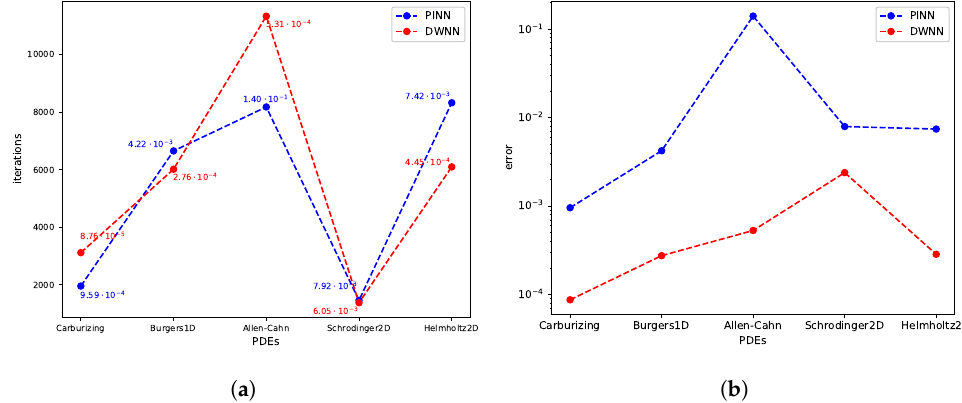
Figure 24. The comparison of iterations and errors. ( a ) Iteration comparison. ( b ) Error comparison. Table 10. The comparison of different methods with respect to relative L 2